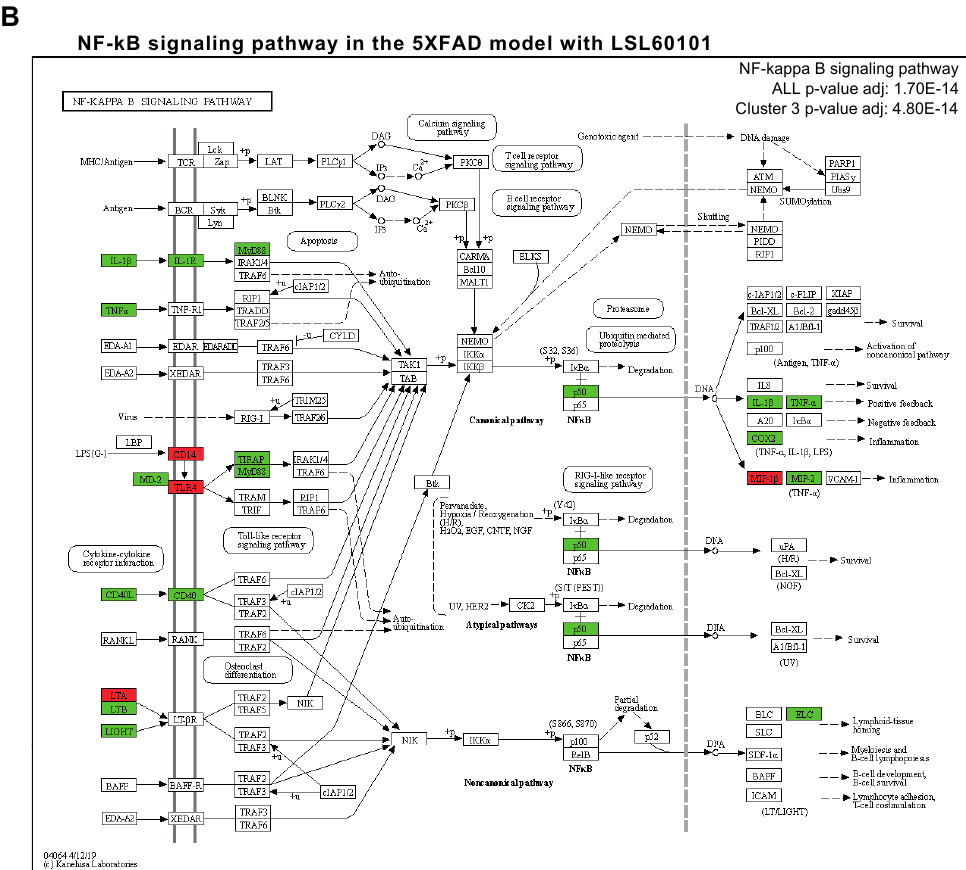
Figure 4. Transcriptional regulatory interactions analysis and NF- κβ signaling pathway. ( A ) The dotplot shows the top TFs involved in the regulation of the clusters identified with TRRUST. An adjusted p -value < 0.05 was considered statistically significant. ( B ) The KEGG pathway map NF- κβ signaling pathway (mmu04064) and the adjusted p -value of the significant clusters are shown. The downregulated (green) and upregulated genes (red) in the 5XFAD control condition versus the 5XFAD LSL60101 condition are shown.